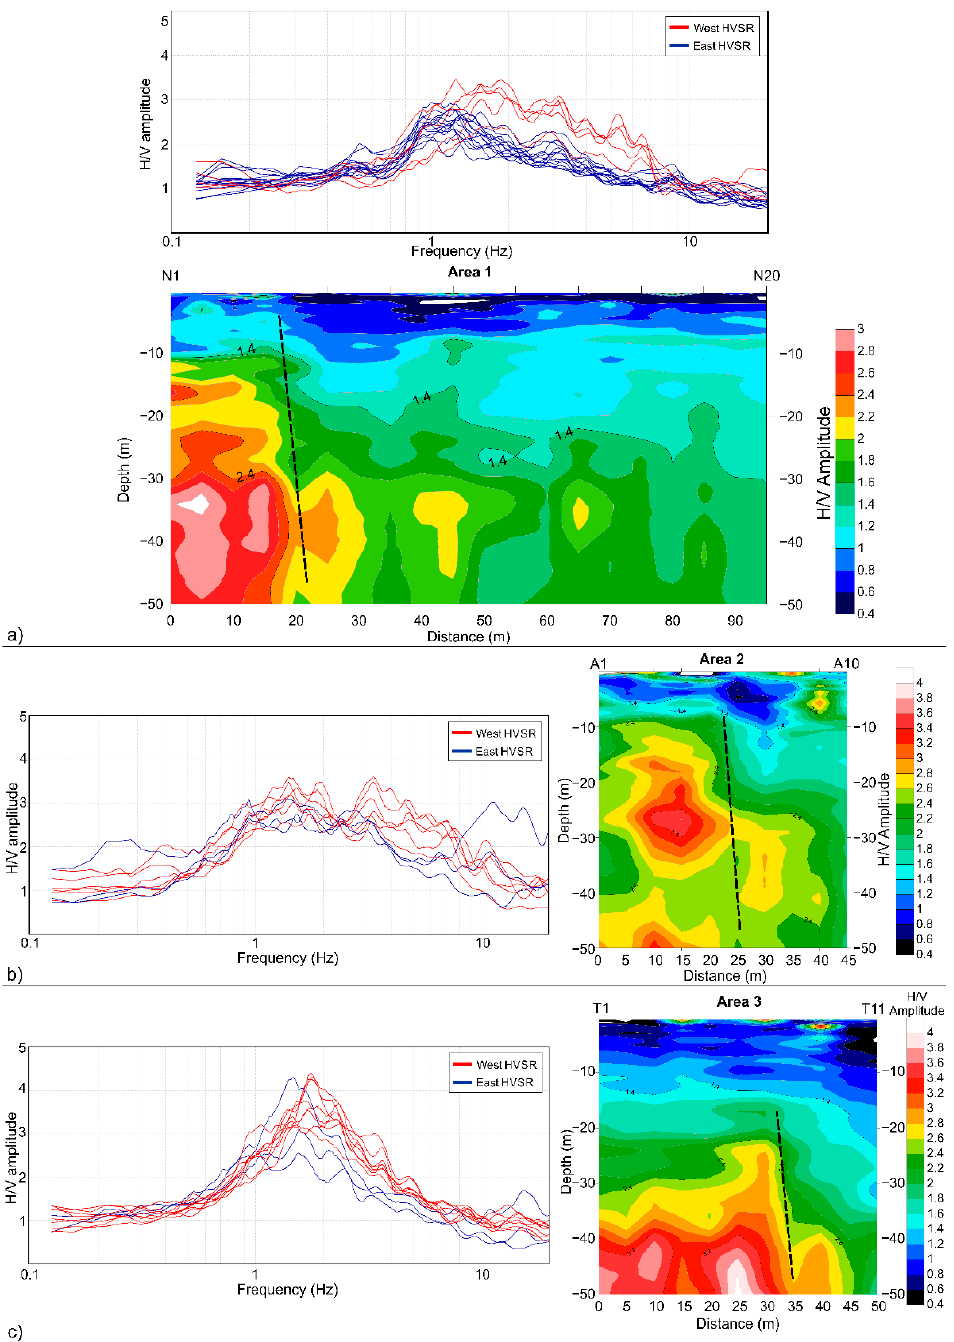
Figure 5. HVSR spectra (the red and blue spectra are related to the measurements sampled at the west and east side of the fault, respectively) and related impedance contrast sections (the dotted line represents the location of TF) for: ( a ) Area 1, ( b ) Area 2 and ( c ) Area 3.